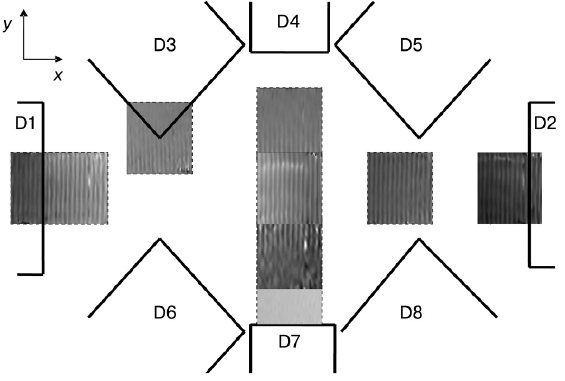
Figure 3. Visualization of SAW on specimen surface.